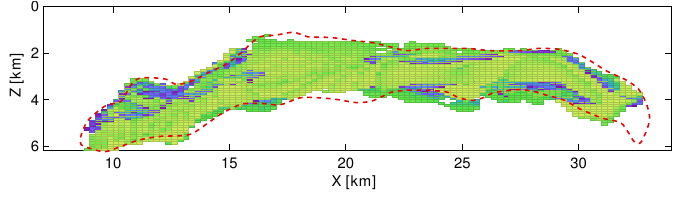
model (Figures 7 and